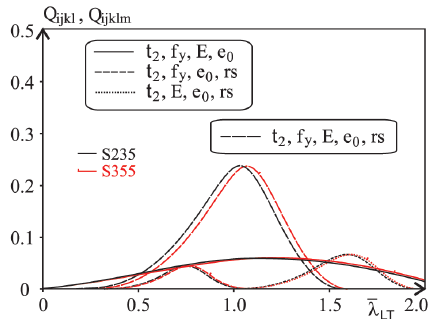
Figure 10. Fourth and fifth order quantile contrast indices 62×46 mm (300×300 DPI)